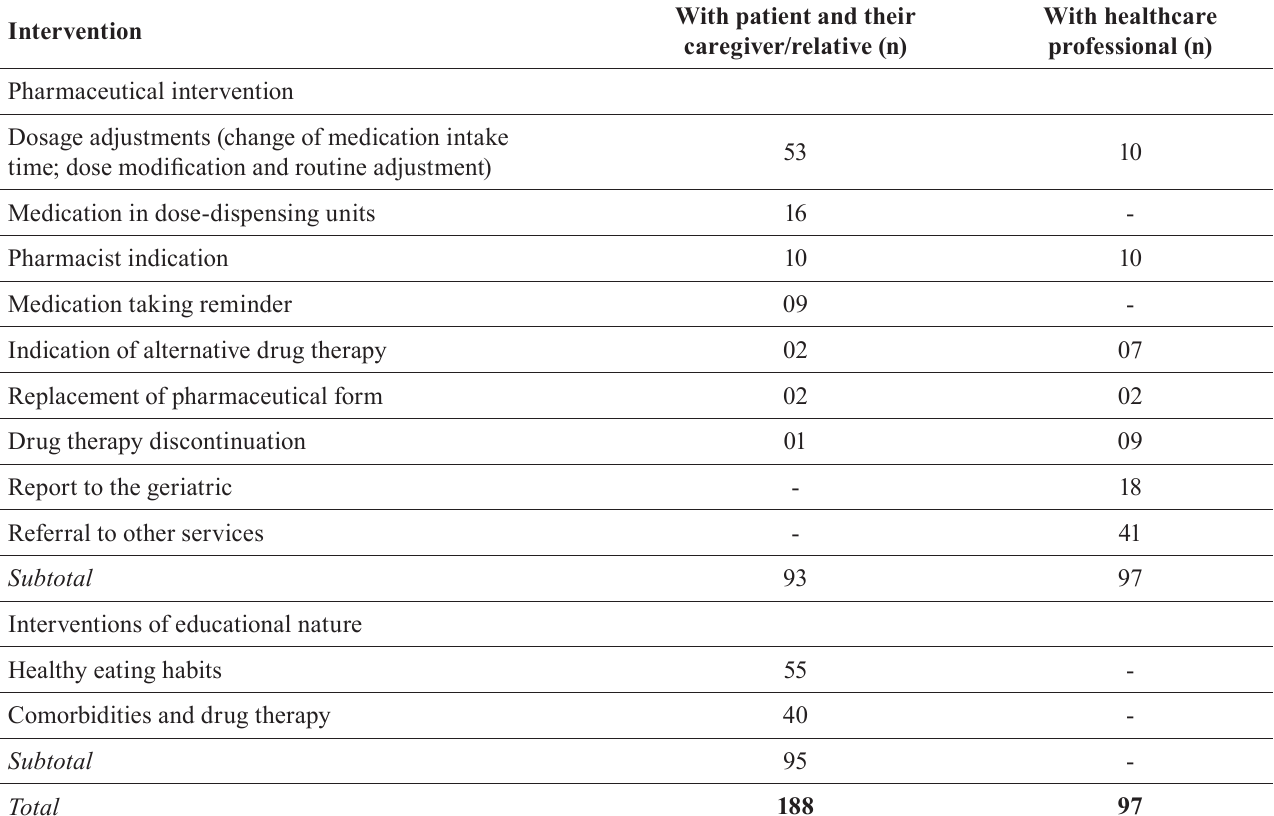
TABLE II - Description of interventions conducted with patients with diagnosis of Alzheimer’s disease and their caregivers/ relatives and health professional and their absolute frequencies, Araraquara Intervention